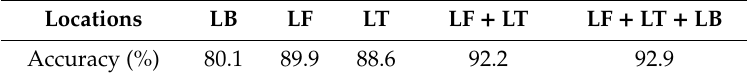
Table 3. Recognition accuracy when using three-axis accelerometer and three-axis gyroscope raw data for di ff erent